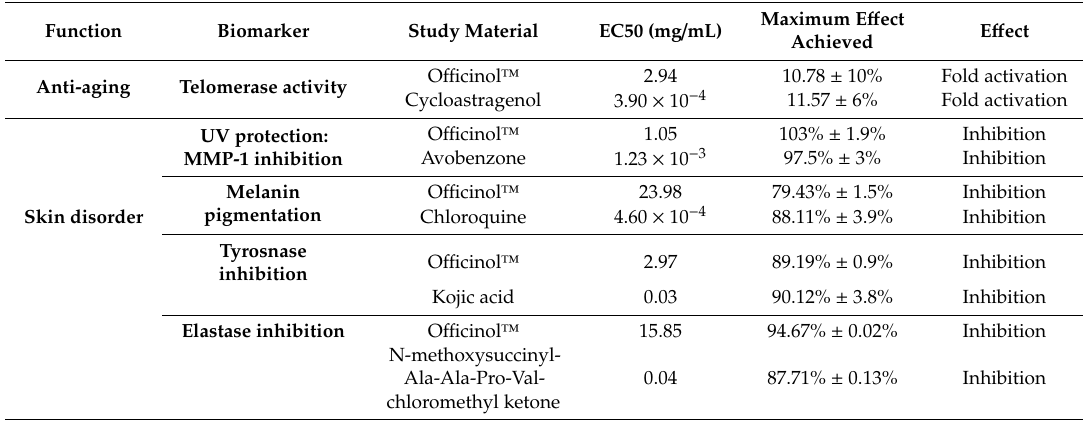
Table 3. E ff ect of O ffi cinol ™ vs. performance standards on biomarkers of aging and skin